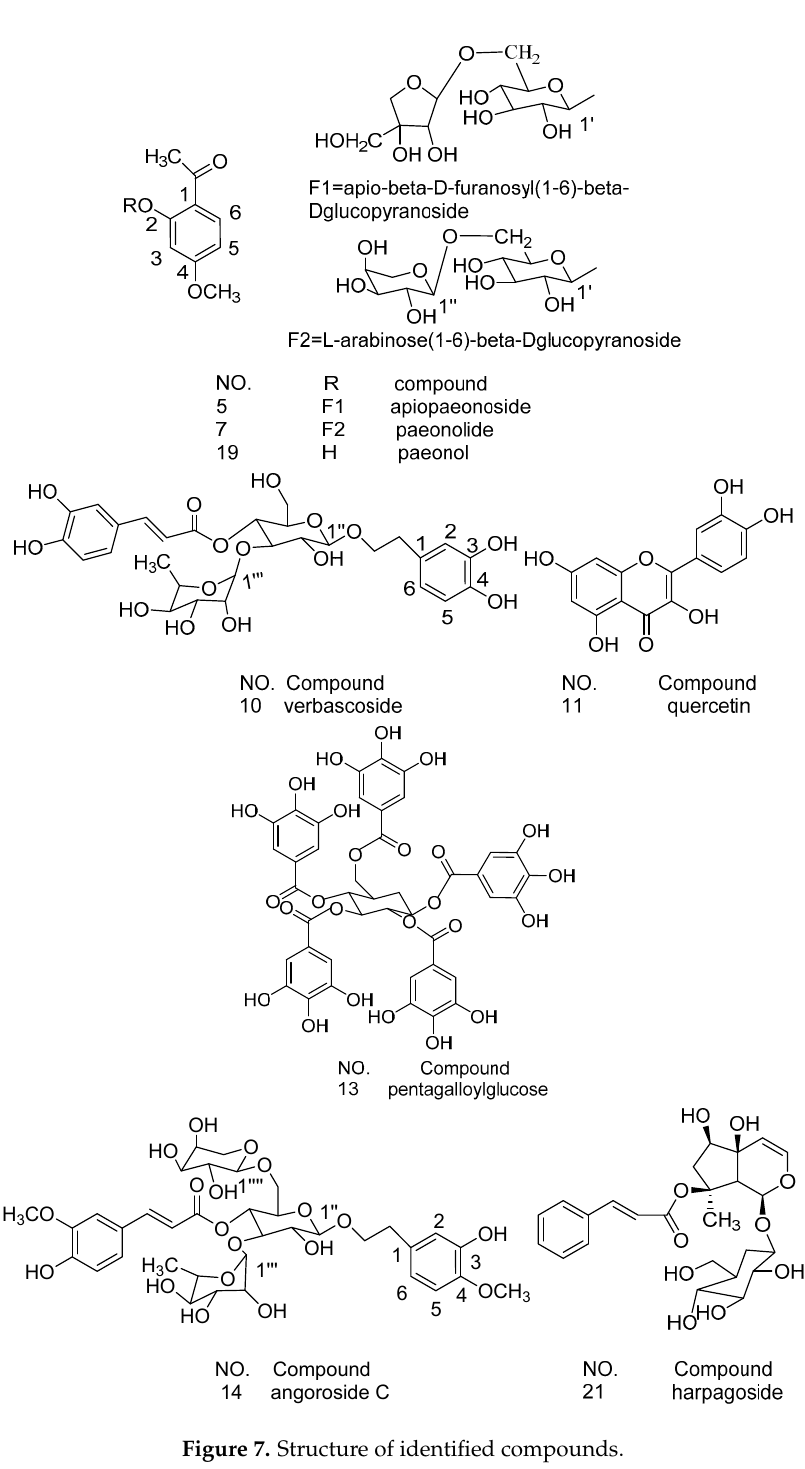
Figure 7. Structure of identified compounds.